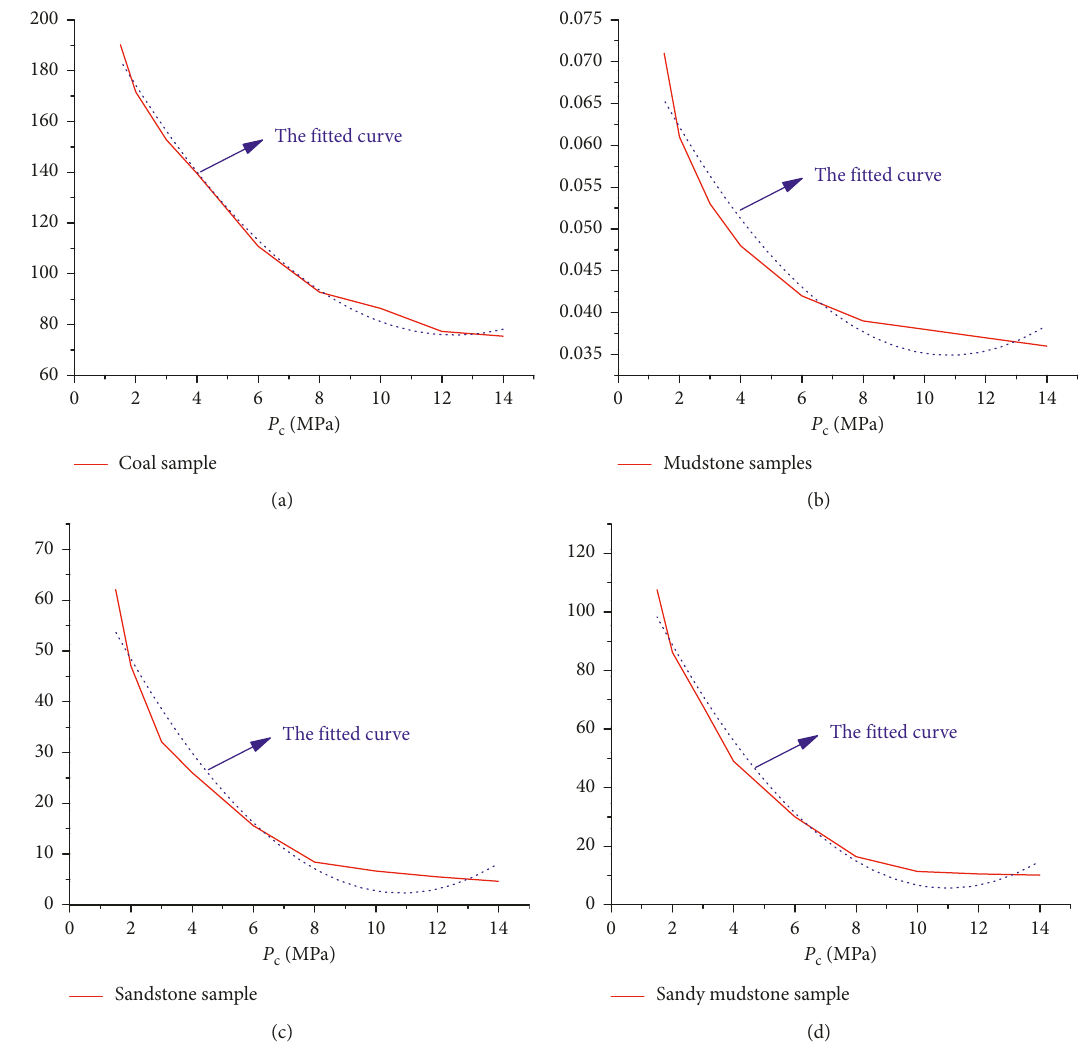
Figure 8: Rock permeability variation rules with different confining